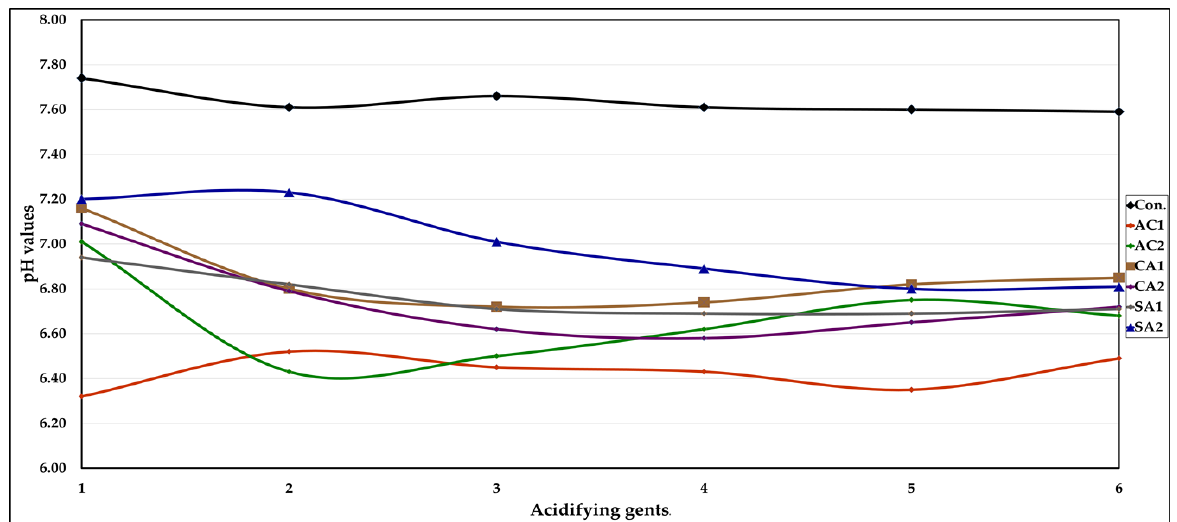
Figure 1. Effect of acidifying agents on the gradual change average in soil pH values during the 2018 and 2019